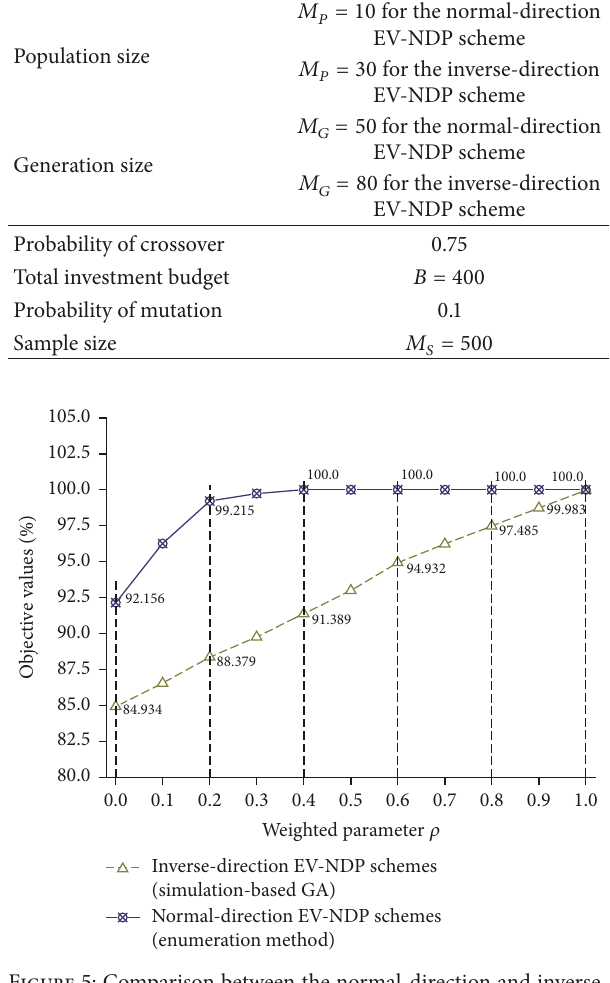
Figure 5: Comparison between the normal-direction and inverse- direction